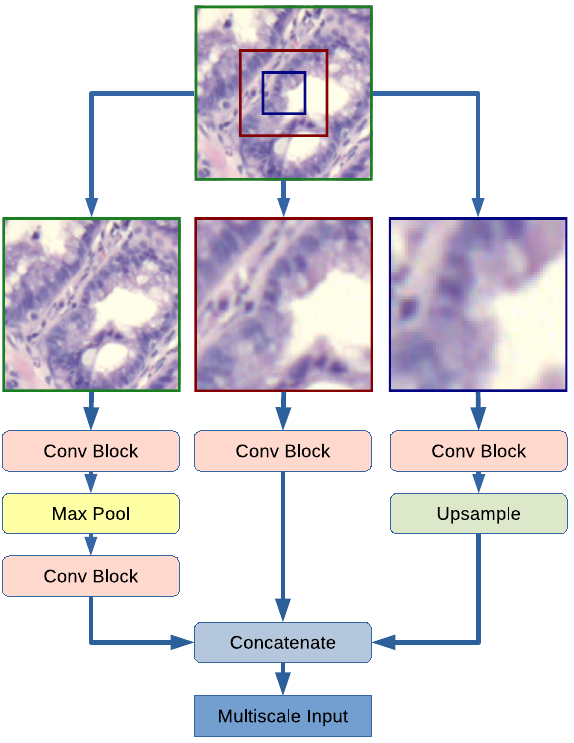
Figure 3. Multiscale input block of the proposed CNN